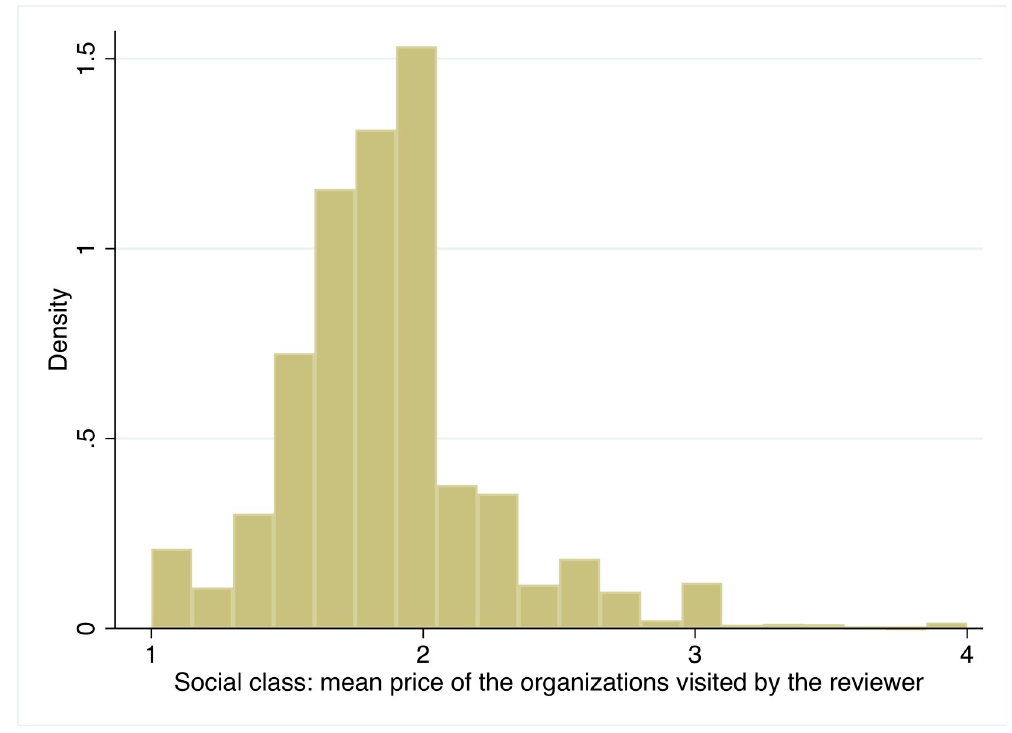
Fig 1. Study 1: Distribution of social class: Mean price of the organizations visited by the reviewer.